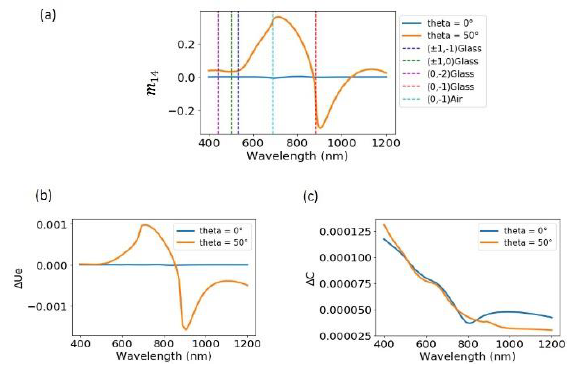
Figure. 2. FEM simulations of (a) far field CD ( (cid:27) DE ) for the gold U metasurface, (b) near field electric energy density and (c) optical chiral density spectra averaged over a box volume around a unit U resonator for normal (blue) and oblique (yellow) incidence. The vertical lines in (a) represent Rayleigh lines corresponding to the sharp edges of the